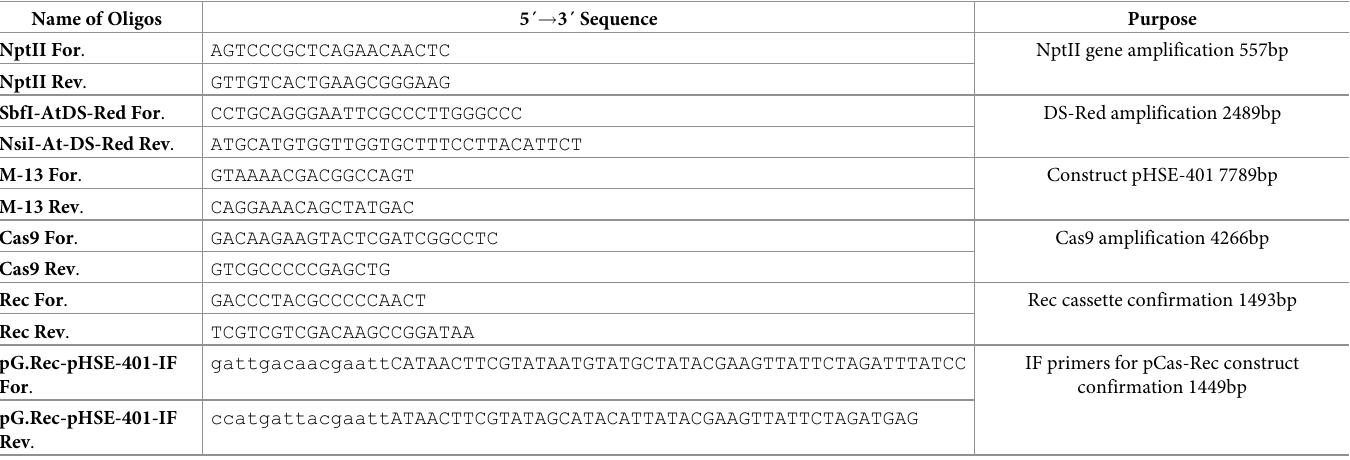
Table 1. Primers used for transgene